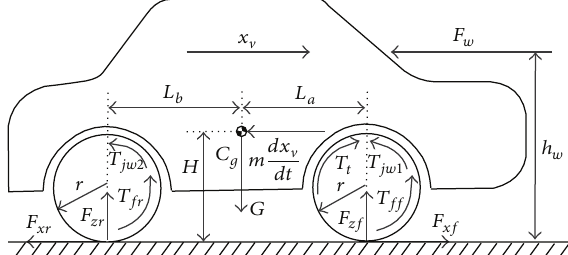
Figure 17: The half vehicle longitudinal motion and force analysis diagram.